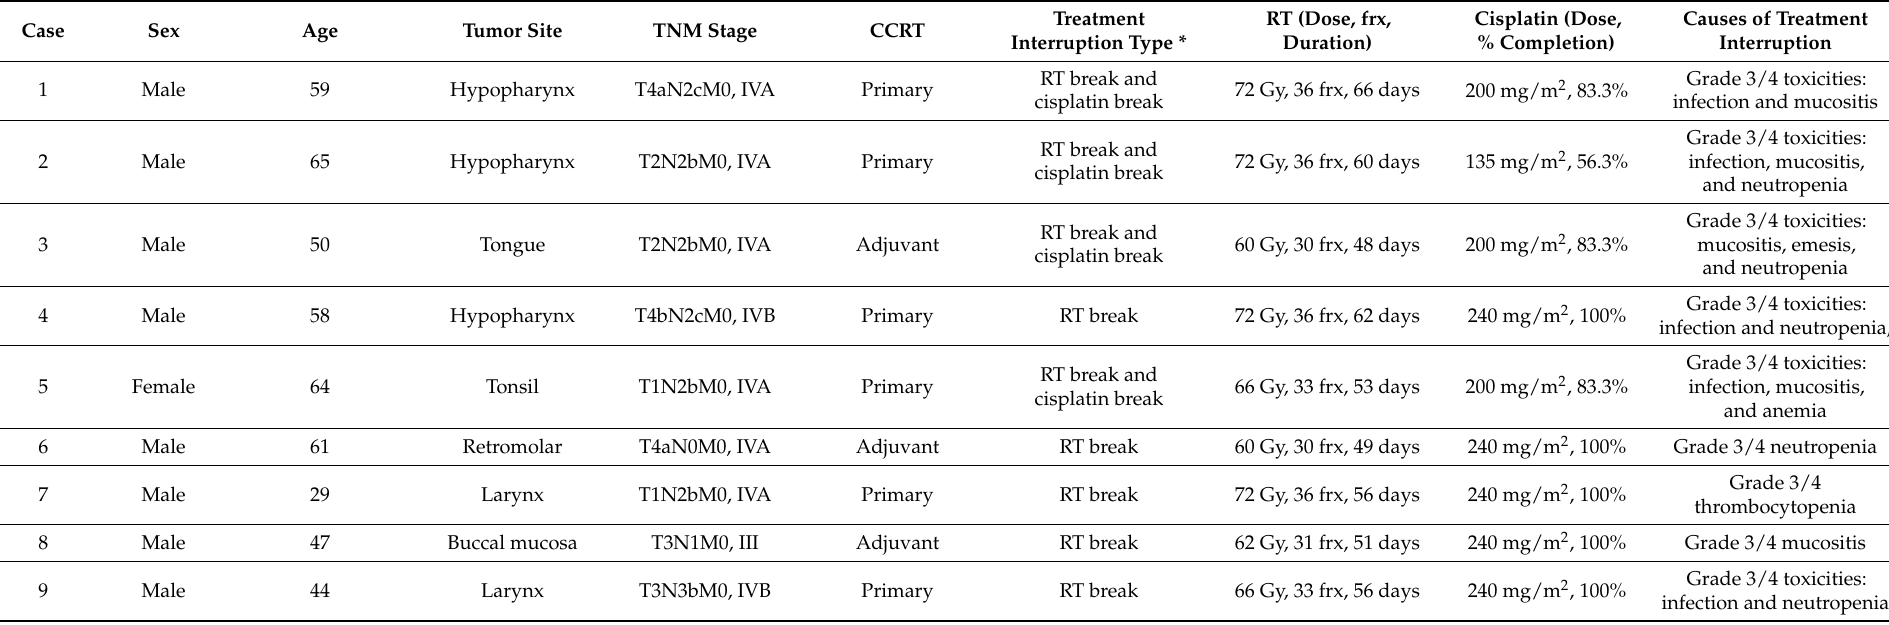
Table 3. Clinical features of nine LAHNSCC patients with treatment interruptions during